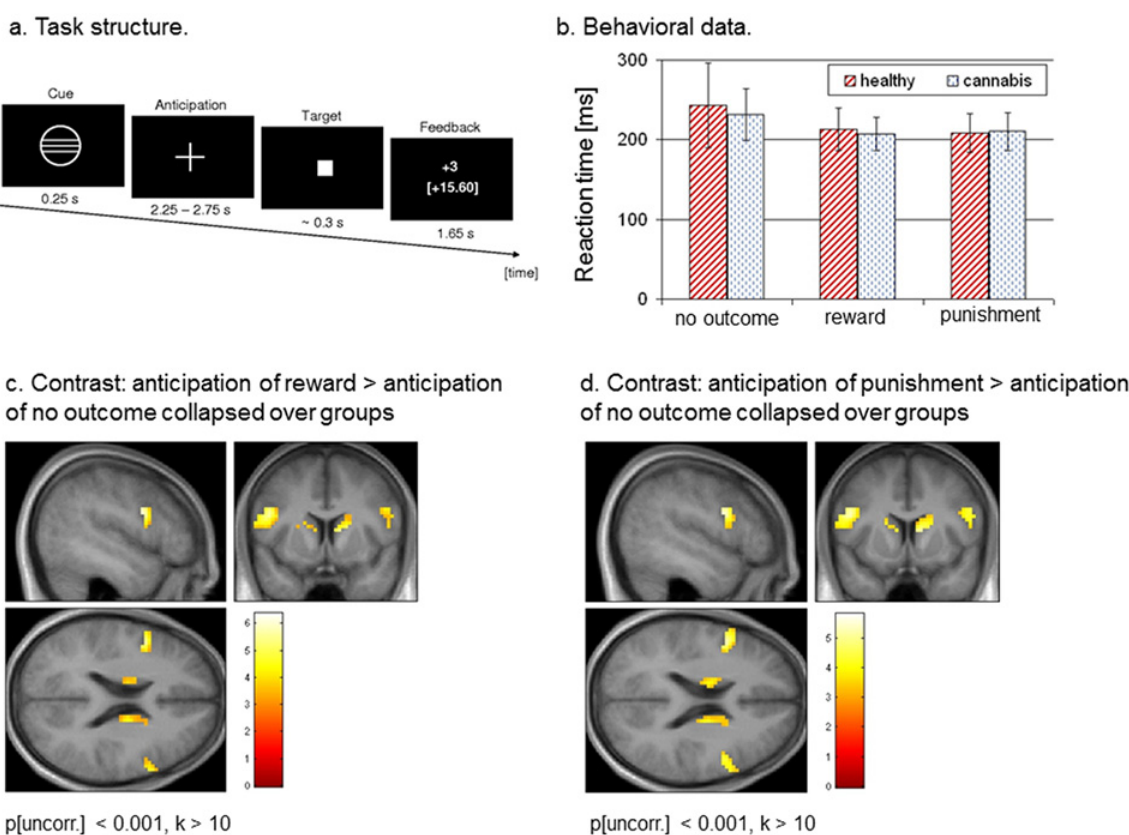
Fig 1. Task design, behavioural data, and fMRI results. a. Design and schematic structure of the applied fMRI paradigm. b. Reaction times for the conditions reward, punishment, and no outcome in healthy subjects and cannabis users. c. Contrast ‘ anticipation of reward > anticipation of no outcome ’ collapsed over both groups. The initial threshold was set to p[uncorr.] < 0.001 for k > 10. d. Contrast ‘ anticipation of punsihment > anticipation of no outcome ’ collapsed over both groups. The initial threshold was set to p[uncorr.] < 0.001 for k > 10.